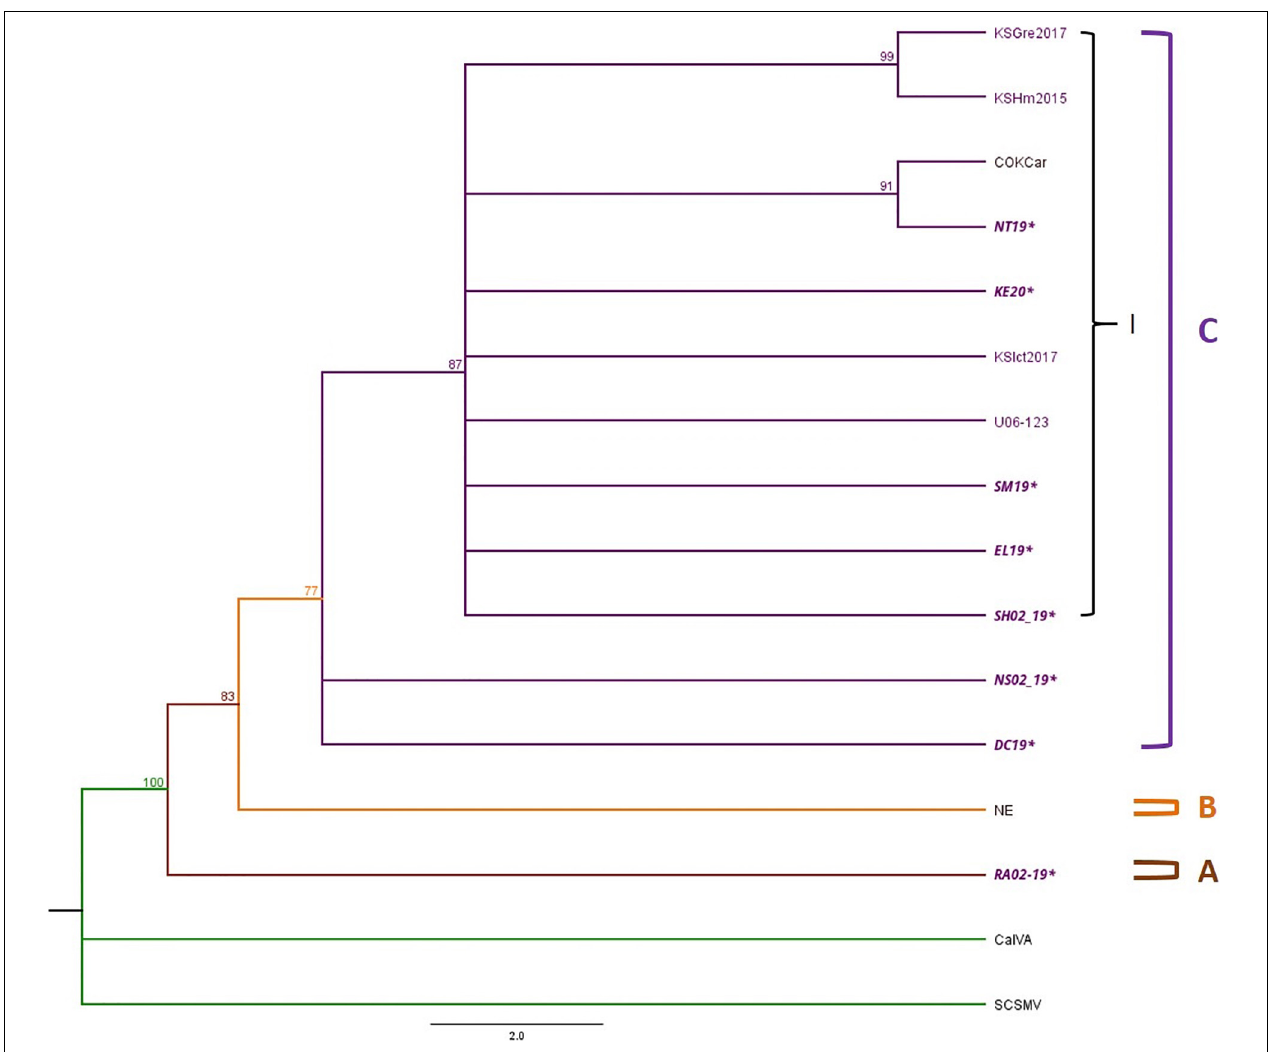
FIGURE 5 | Phylogenetic tree of TriMV isolates is divided into Clades A–C and Clade C contains sub-clade I. The Bayesian phylogenetic tree of the complete genome sequences of TriMV consisted of eight field isolates 2019 and 2020 and six isolates obtained from the GenBank. The sample IDs of Kansas isolates are written in purple text, and the isolates sequenced in this study are written in bold and italicized text. The posterior probability of 70% was the cutoff value, and branches not supported were